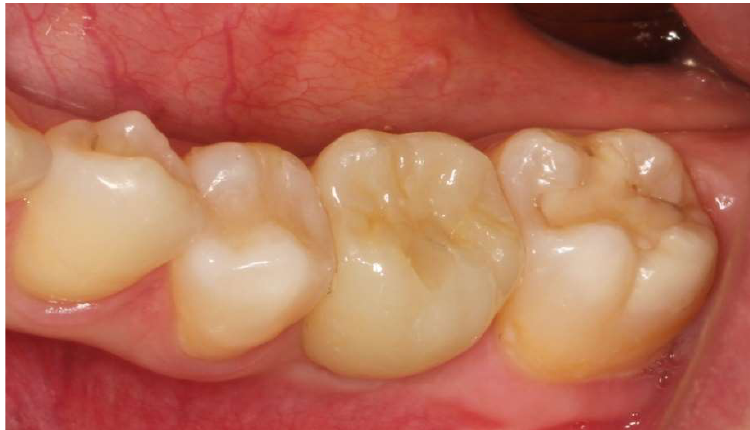
Figure 4. The screw-retained ceramic crown of tooth 36.